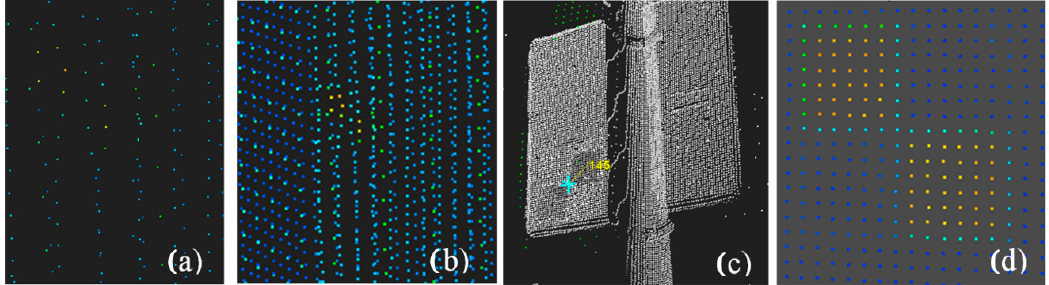
Figure 3. Target scans with different representation qualities. ( a ) and ( b )–sparse points; ( c ) and ( d )–dense point clouds.